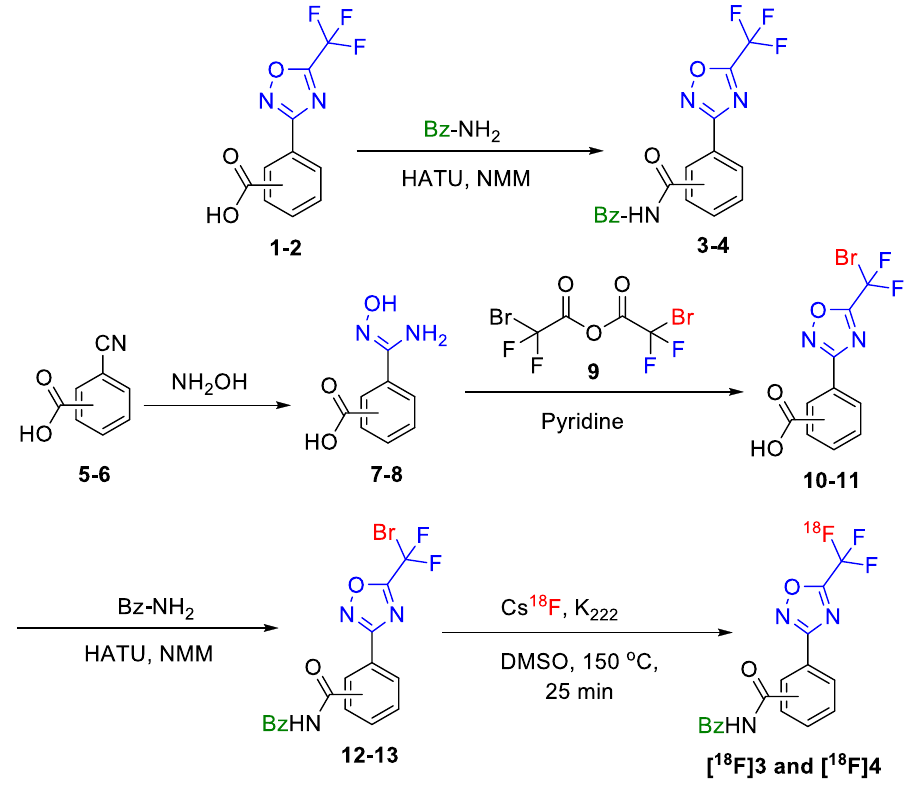
Figure 2. Radiosynthesis of 18 F-TFMO containing